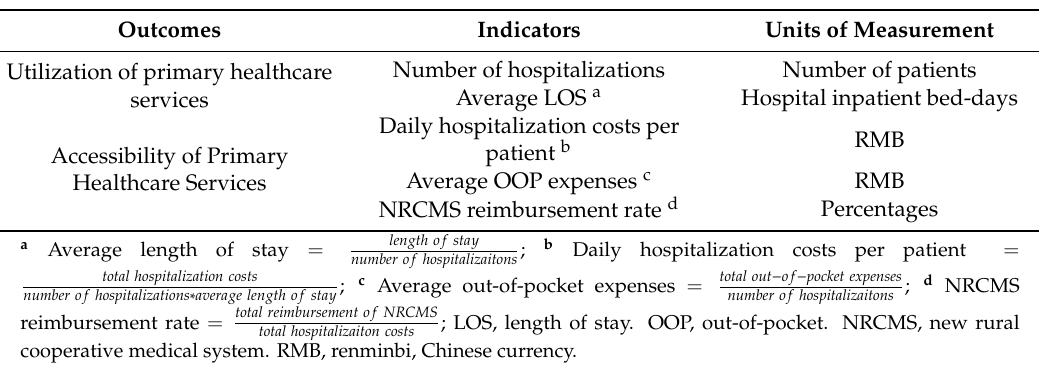
Table 1. Study outcome